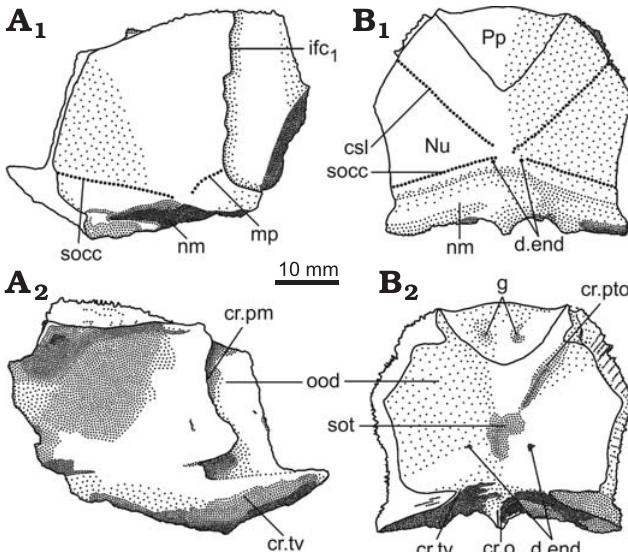
Fig. 7. Antiarchan fish Bothriolepis leptocheira jeremejevi (Rohon, 1900), paranuchal (A) and postpineal and nuchal (B), plates of the head shield. A . IG KSC 155/117 in dorsal (A 1 ) and visceral (A 2 ) views. B . Articulated plates IG KSC 155/154 in dorsal (B 1 ) and visceral (B 2 ) views. Abbreviations: cr.o, median occipital crest of head shield; cr.pm, paramarginal crest of head shield; cr.pto, postorbital crest of head shield; cr.tv, transverse nuchal crest of head shield; csl, central sensory line groove; d.end, opening of canal for endolymphatic duct; g, paired pits on Pp; ifc 1 , principal section of infra- orbital sensory line; mp, middle pit-line groove; nm, obtected nuchal area of head shield; Nu, nuchal plate; ood, otico-occipital depression of head shield; Pp, postpineal plate; socc, supraoccipital cross-commissural pit-line groove; sot, supraotic thickening of head shield.